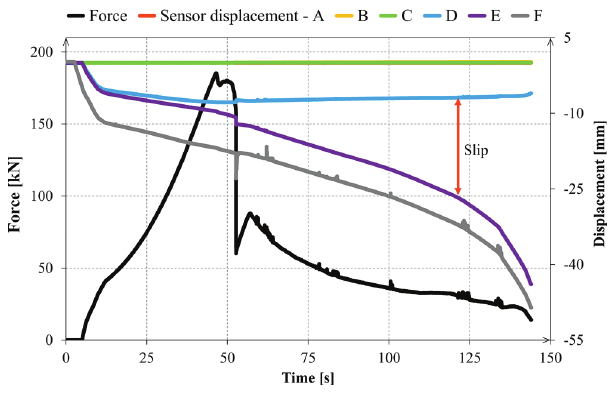
Fig. 9. Changes of displacements